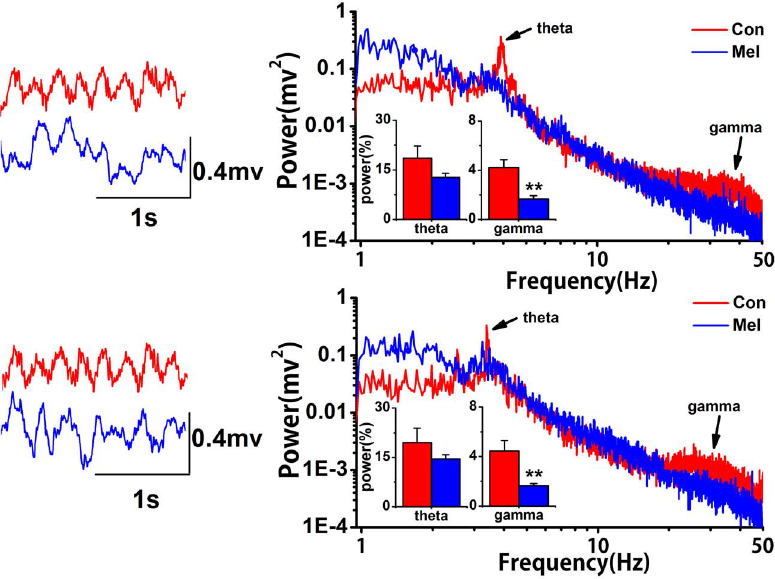
Figure 1. The representative LFPs and the corresponding power spectra in CA3 and CA1 regions. A. Left: The original traces of LFPs in CA3 region from a Con rat (red line) and a Mel rat (blue line). Right: The corresponding power spectra distributing from 1 Hz to 50 Hz of the two rats. Arrows present some theta and gamma rhythms. The inserts show statistical results of relative power in theta and gamma rhythms in two groups. B. Left: The original traces of LFPs in CA1 region from a Con rat (red line) and a Mel rat (blue line). Right: The corresponding power spectrum distributing from 1 Hz to 50 Hz of the two rats. Arrows present some theta and gamma rhythms. The inserts show statistical results of relative power in theta and gamma rhythms in two groups. **p , 0.01 comparison between Mel group and Con group.